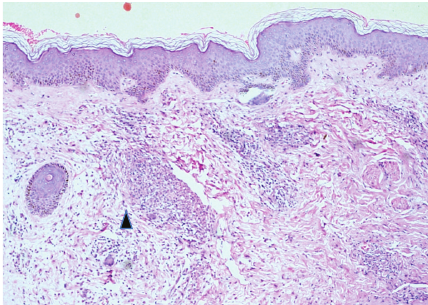
Figure 4: Skin biopsy from leg (hematoxylin and eosin stain, 20X magnification) showing largely unremarkable epidermis. Dermis shows collection of foamy histiocytes (black arrowhead).